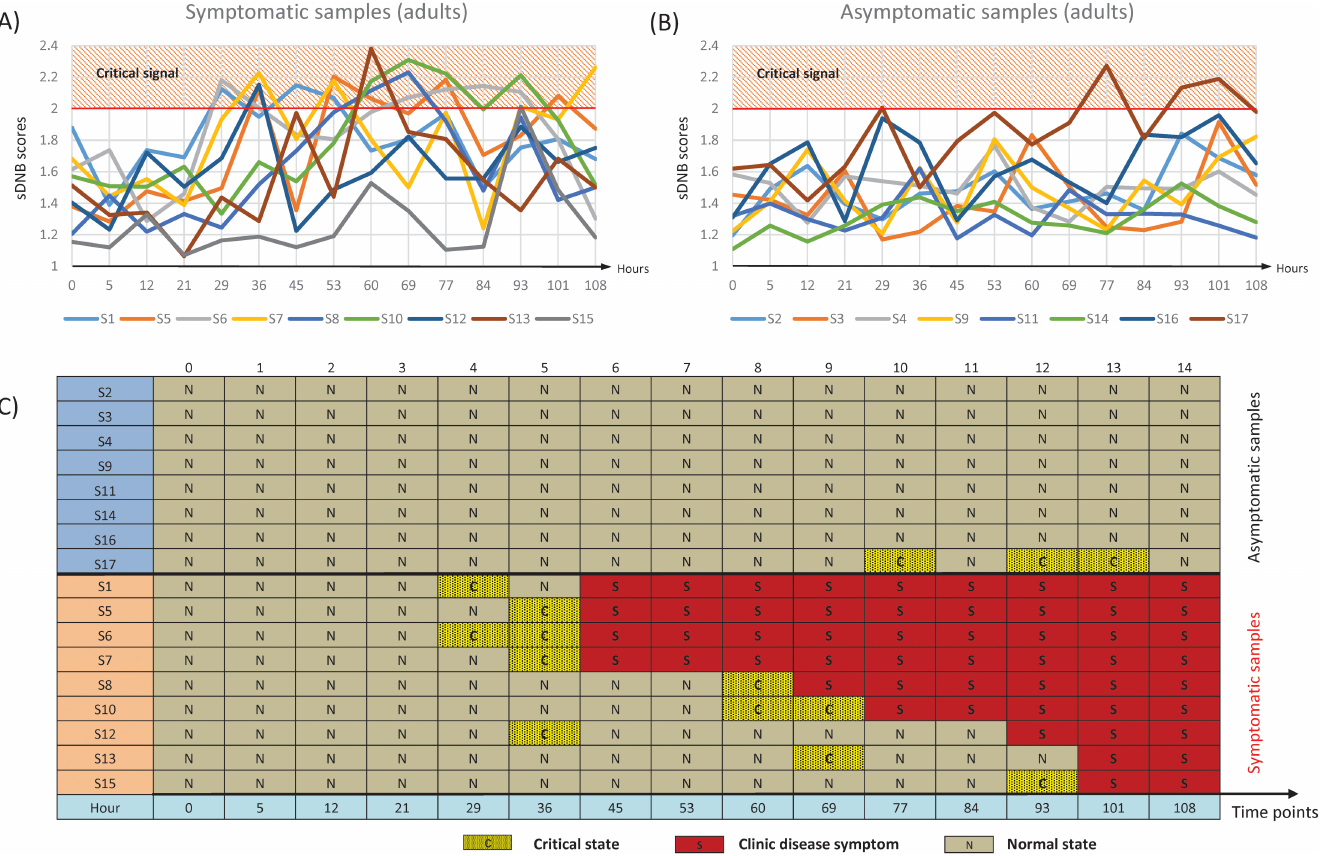
Fig 3. Quantifying the critical states for the influenza virus infection data [8]. (A) Line chart for early-warning signalsin all symptomatic adults. (B) Line chart for early-warning signals in all asymptomatic adults. (C) Table of sDNB diagnoses and clinicaldiagnosesfor all adults and samples.